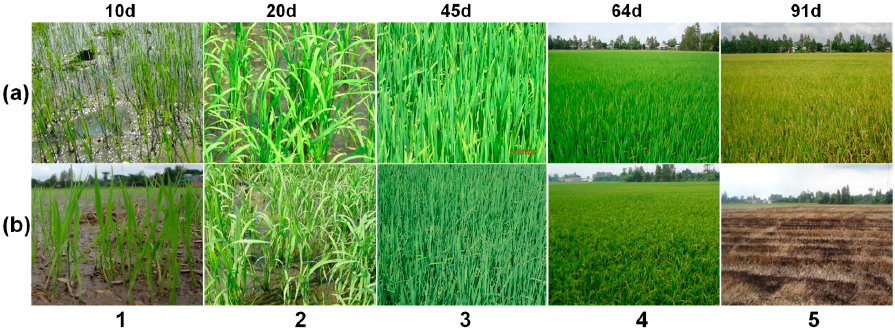
Figure 5. Ground survey photos at 10, 20, 45, 64, 91 days after sowing: ( a ) Long cycle rice variety, ( b ) Short cycle rice variety.